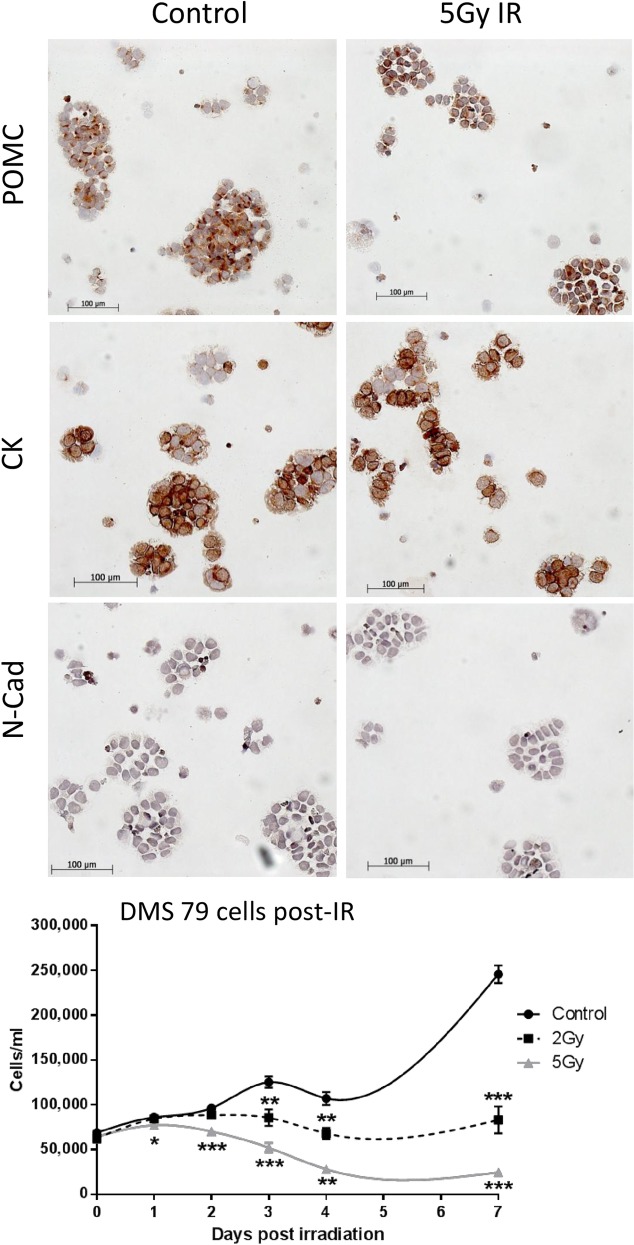
DMS 79 phenotype is not altered after one irradiation cycle in vitro.DMS 79 cells were counted on day 0 and then irradiated at 2Gy and 5Gy. Viable counts were conducted up to 7 days post-irradiation before cells were stained for POMC, cytokeratin (CK) and N-Cadherin. All irradiation cycles were conducted on 3 independent cultures. * p = <0.05 ** p = <0.01 *** p = <0.001